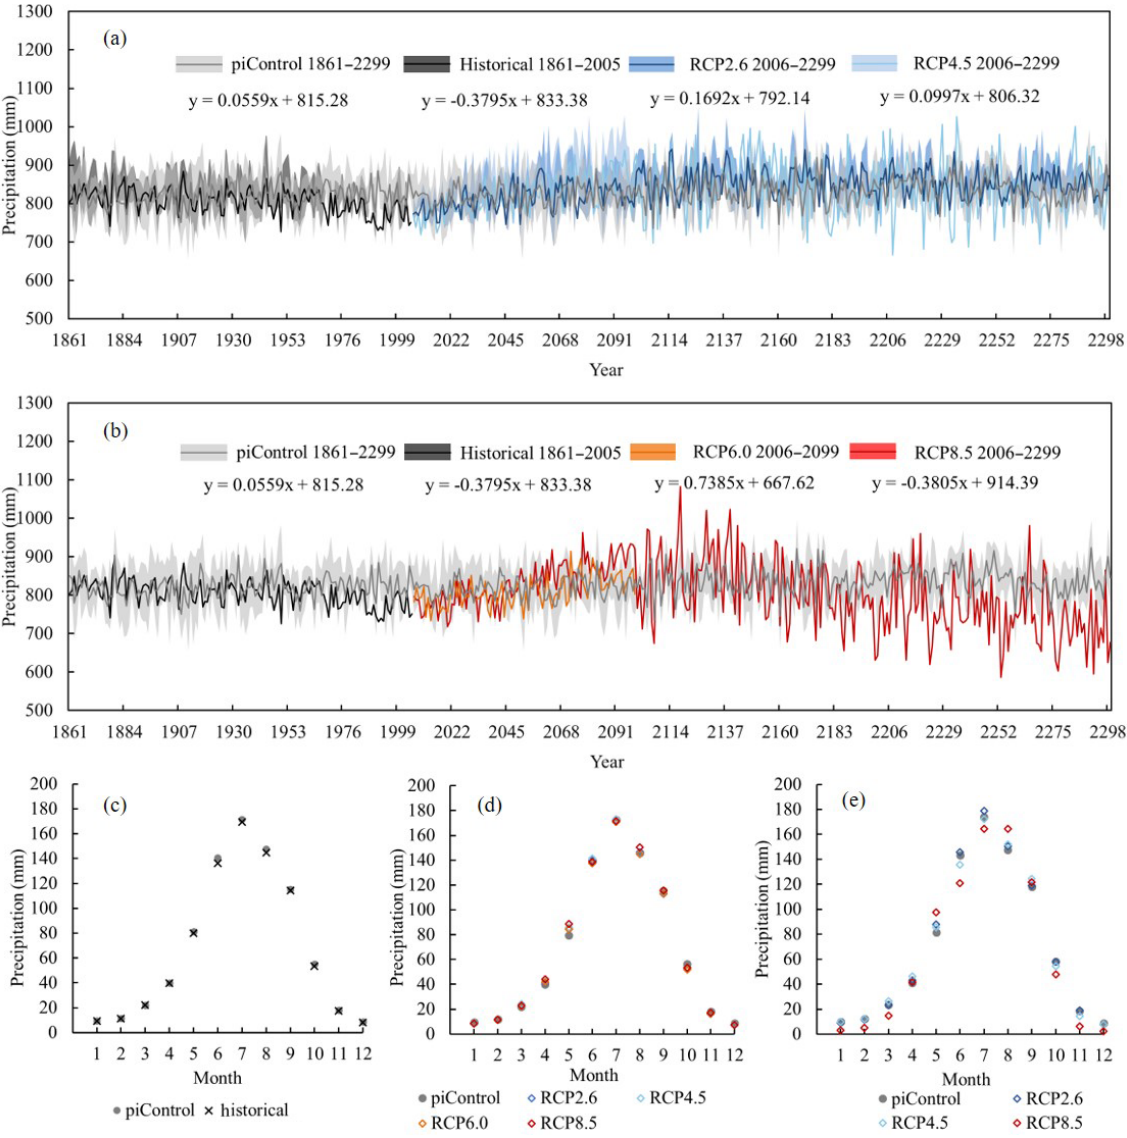
Figure 4. Inter-annual (a, b) and long-term averaged monthly dynamics (c–e) of precipitation in the upper Yangtze River basin: comparison of the piControl scenario with the anthropogenic climate change scenarios (periods: a : 1861-2299; b : 1861-2299; c : 1861–2005; d : 2006– 2099; and e :